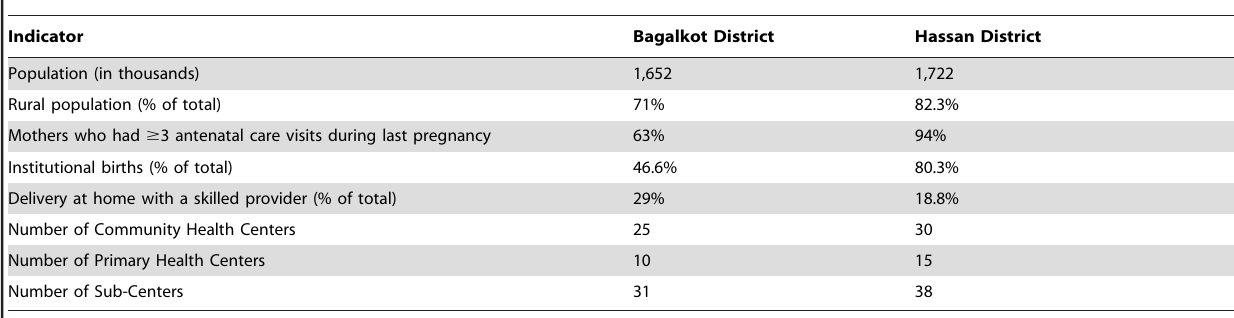
Table 1. Bagalkot and Hassan District Profiles.